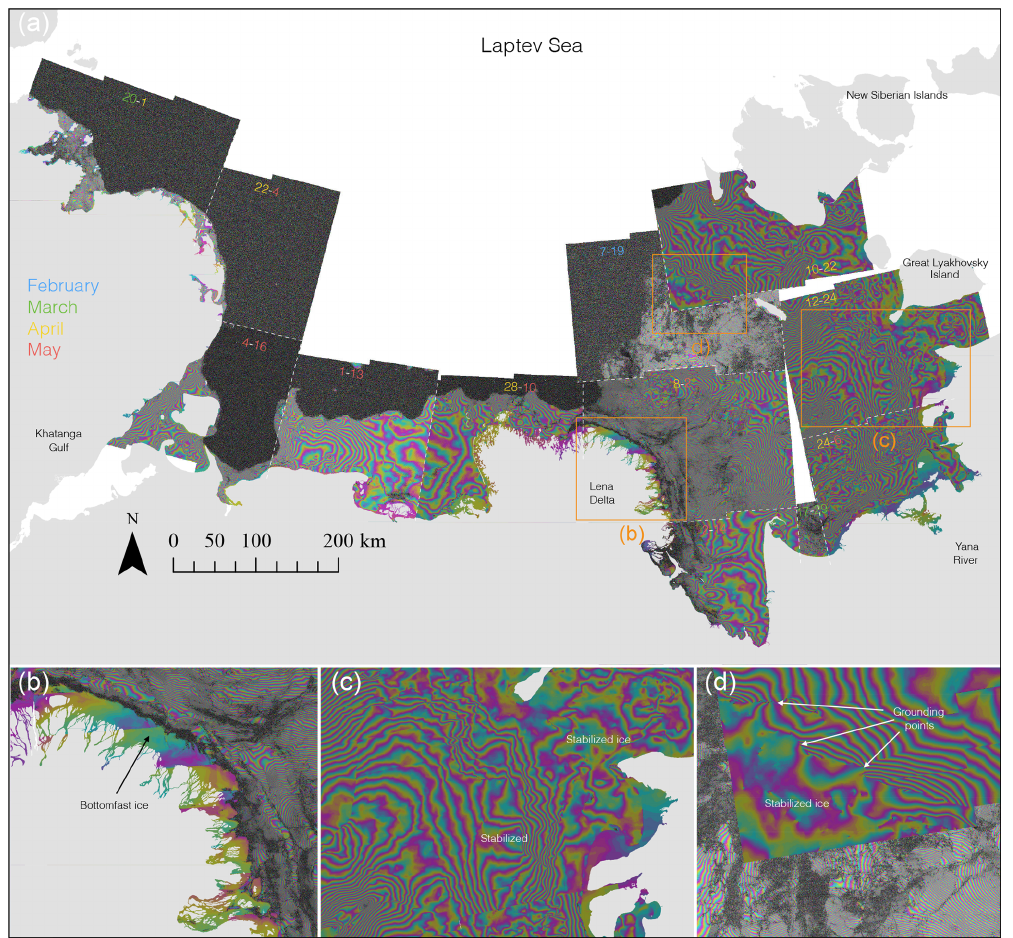
Figure 7. (a) Sentinel-1 interferograms derived from image pairs acquired over the Laptev Sea between February and May 2017. Numbers on images represent date ranges. The colors blue, green, yellow, and red signify the months of February–May. (b, c, d) Three enlarged areas identified in (a) are further discussed in the